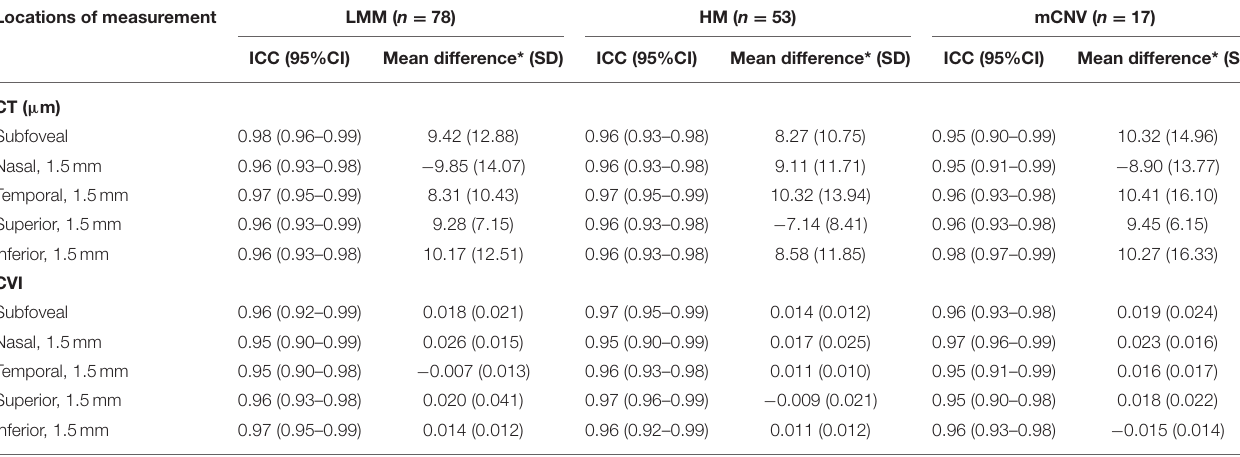
TABLE 2 | Intraobserver reliability of choroidal parameters in LMM, HM, and mCNV groups at different locations. Locations of measurement